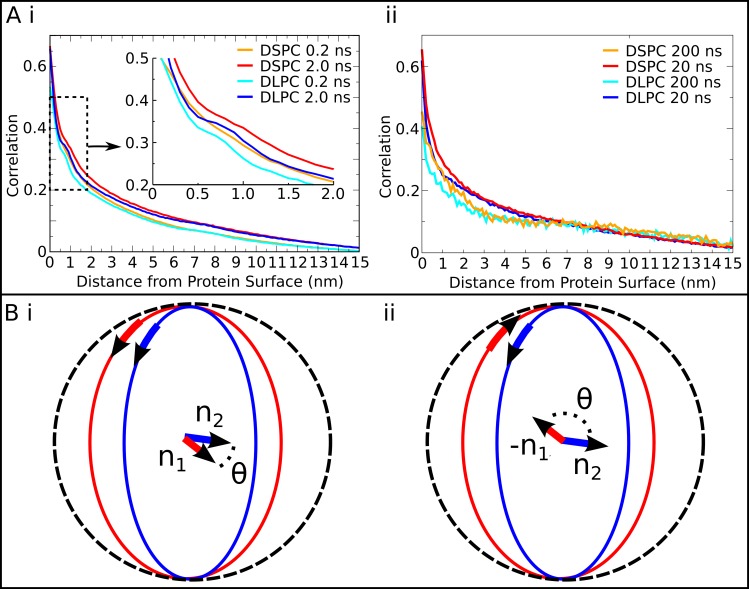
Protein aggregate associated lipid sorting.(A) i) The direction correlation of lipid and protein displacements as a function of distance from the proteins after 0.2 ns or 2.0 ns time jumps. The data have been averaged for all proteins and over the full length of the trajectories. The correlations are shown separately for DLPC and DSPC lipids; ii) The direction correlation of phospholipids (DLPC and DSPC) and OmpF displacements for time jumps of 20 ns or 200 ns are shown as a function of the phospholipid distance from the surface of the protein. The correlation was calculated as an average over all lipids and protein movements over the course of the trajectories. Fewer data points exist for longer time jumps, leading to incomplete convergence of the correlation measure. (B) Schematic description of the calculation of the direction correlation. The direction correlation is related to the angle between the axes of rotation of two lipids, red (n1) and blue (n2), traveling on great circles, (i). In the opposite direction of travel (ii), the axis of rotation is negative, (-n1). The dot product of the two axes of rotation vectors yields cos(θ), the measure of direction correlation (see Methods section for full details of the calculation).